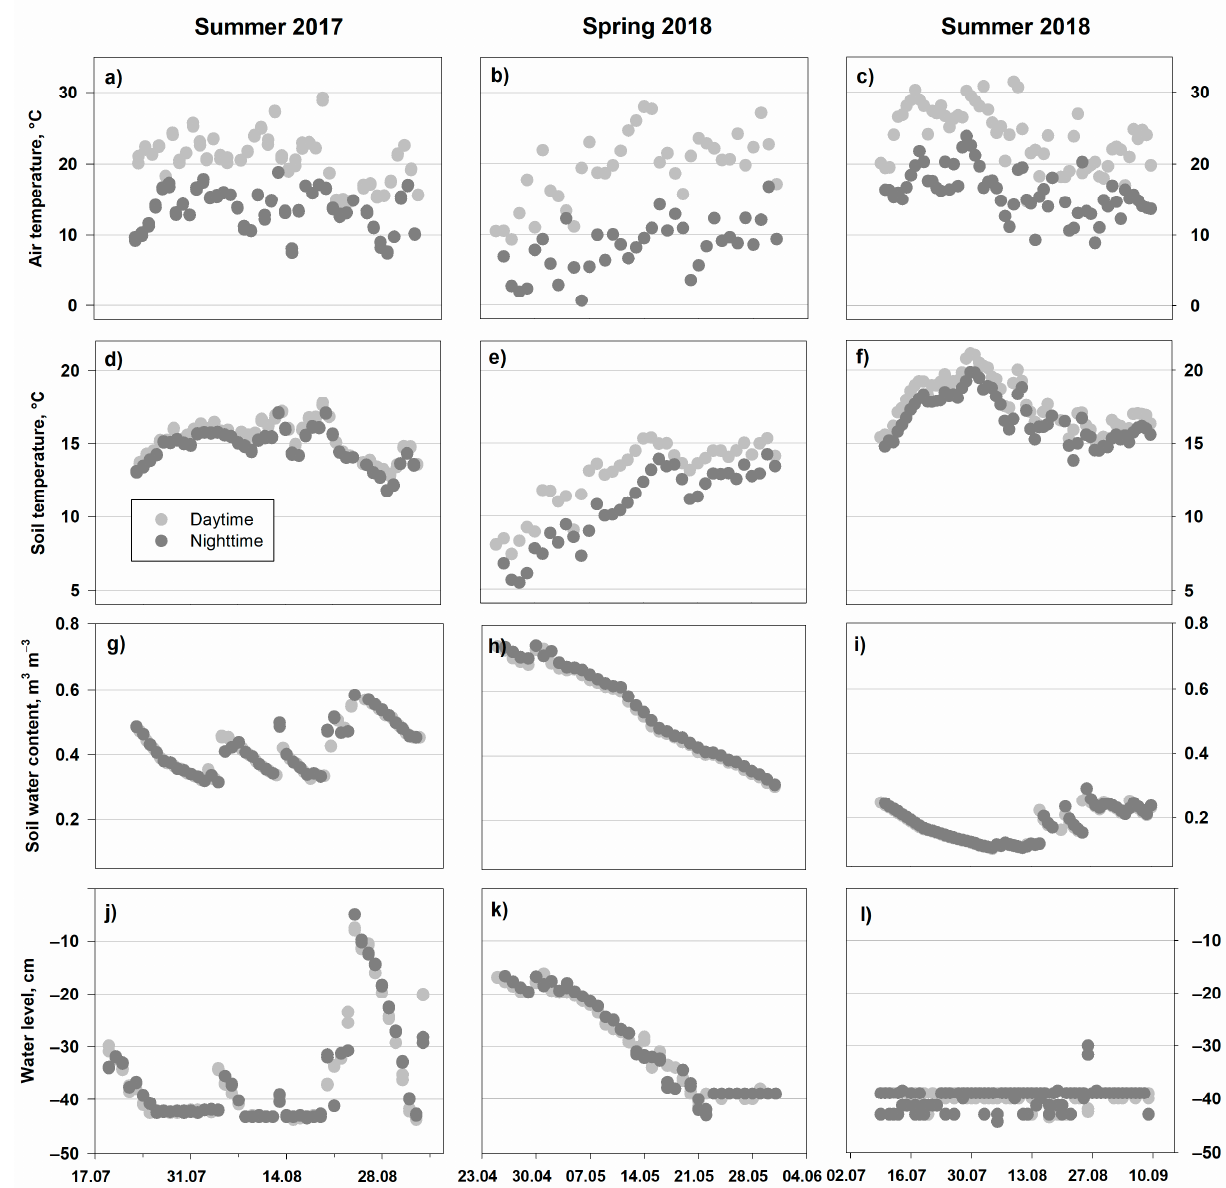
Figure 1. Environmental parameters for the three study periods: ( a – c ) air temperature; ( d – f ) soil temperature at 5 cm depth; ( g – i ) soil water content at 5 cm depth; ( j – l ) soil water level. Averaged values from 12 measuring points (air temperature from one central point) at 12:00 and 00:00 per day are presented.